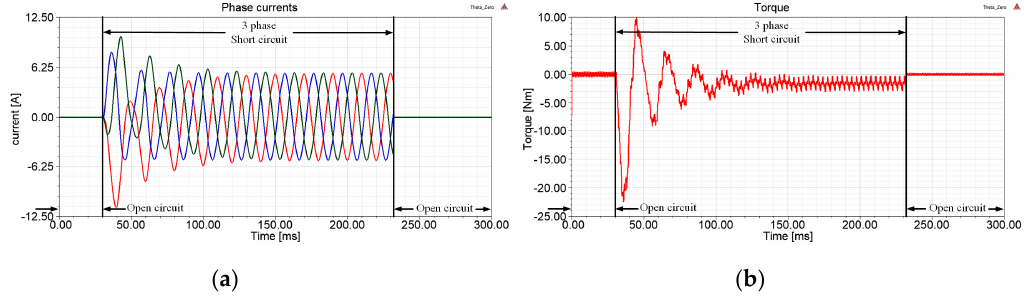
Figure 17. Open circuit–short circuit–open circuit test at 150 °C: ( a ) currents and ( b ) torque.